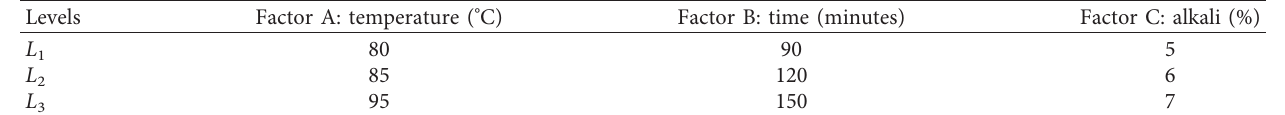
Table 1: Factors and levels information in the